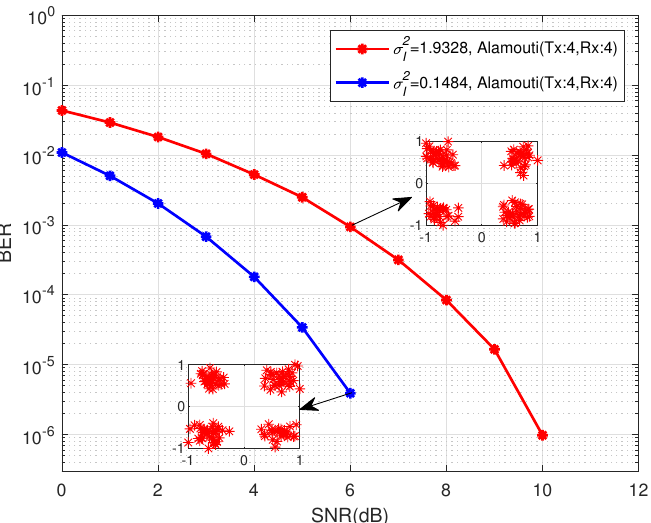
Figure 10. BER curves of 4 × 4 STBC coding system under different turbulent environments.